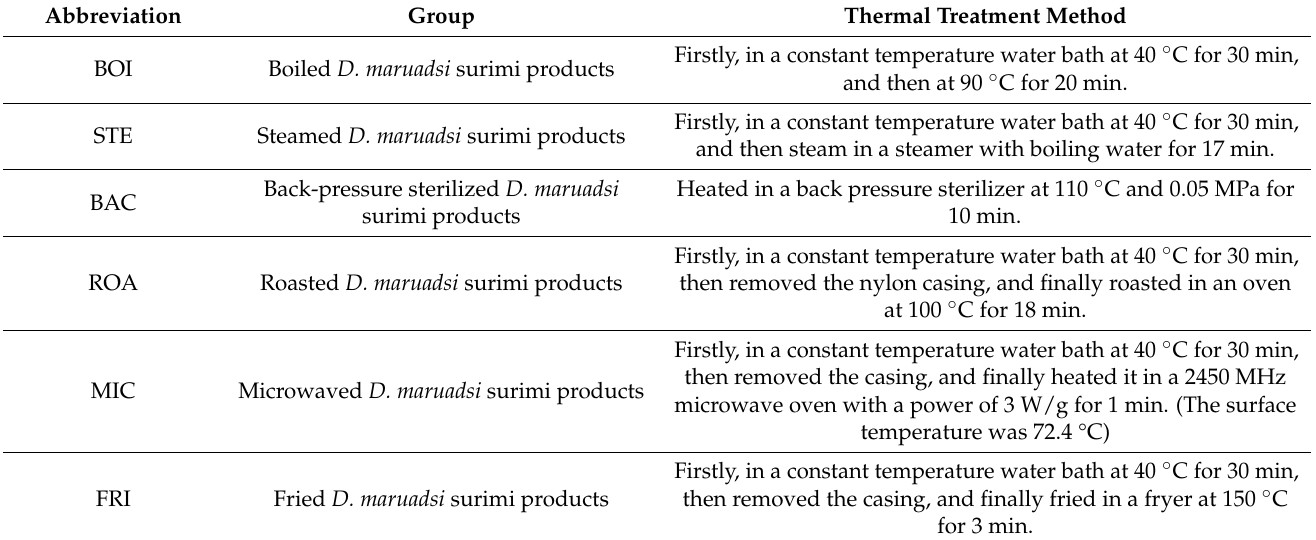
Table 1. The process for preparing D. maruadsi surimi products using different thermal treat- ment